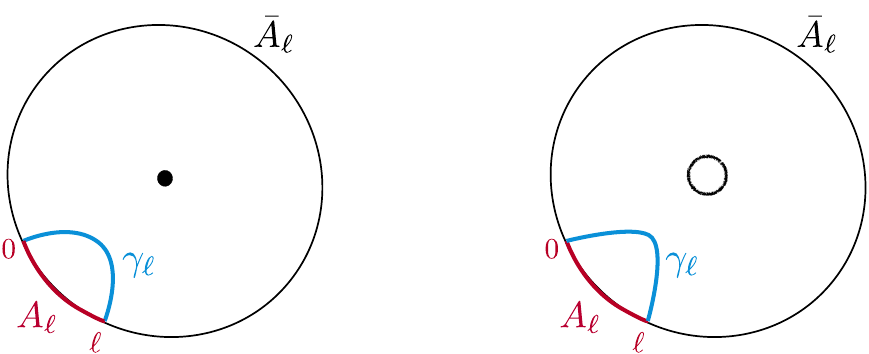
Figure 1 . Schematic depiction of the extremal surfaces when the spacetime is the M = 0 BTZ black hole (left) and that of a microstate with macroscopic h J i (right). We work entirely in the CFT and so make no use of these surfaces, but their correspondence with the boundary entropies is precise